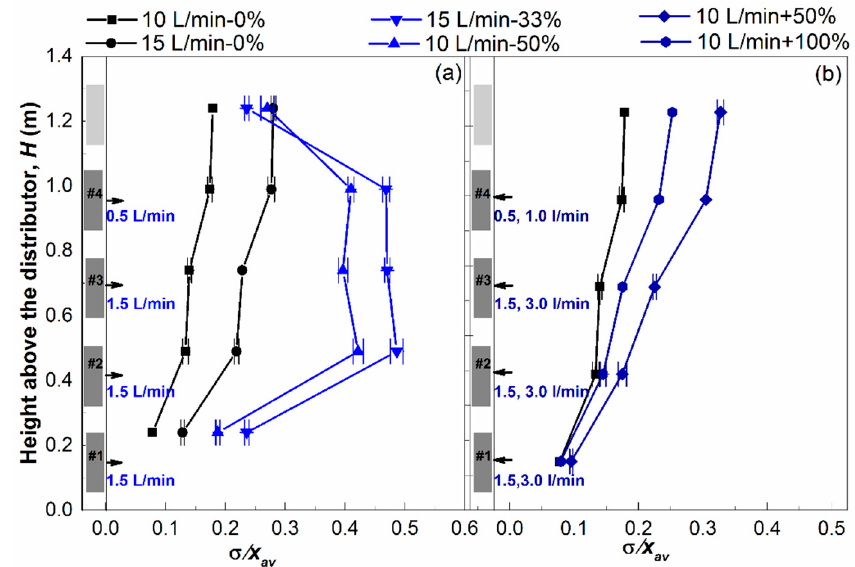
Figure 2. Effects of ( a ) gas extraction and ( b ) gas addition through porous membranes on the σ r of the differential pressure signals. The other operation conditions: T = 550 °C, P = 0.1 MPa, H ini = 1.28 m, calcined dolomite.